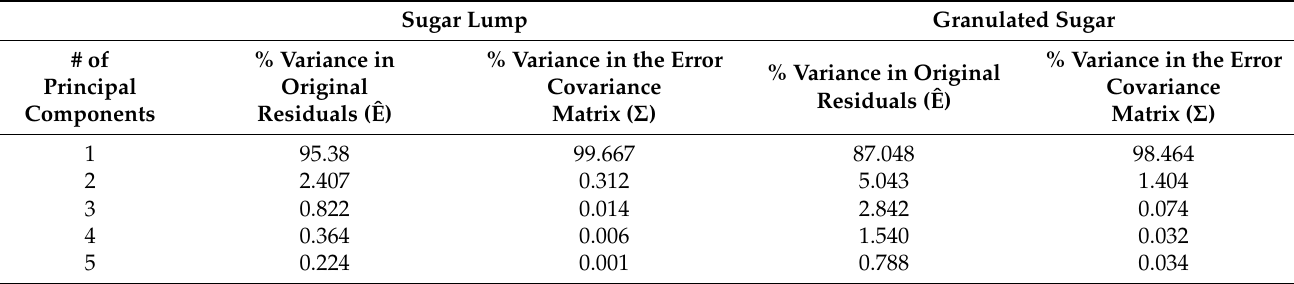
Table 3. Percentage of variance accounted for in the original matrix of residuals as well as in the error covariance matrix by PCA models of increasing complexity for NeoSpectra Scanner data. Sugar Lump Granulated